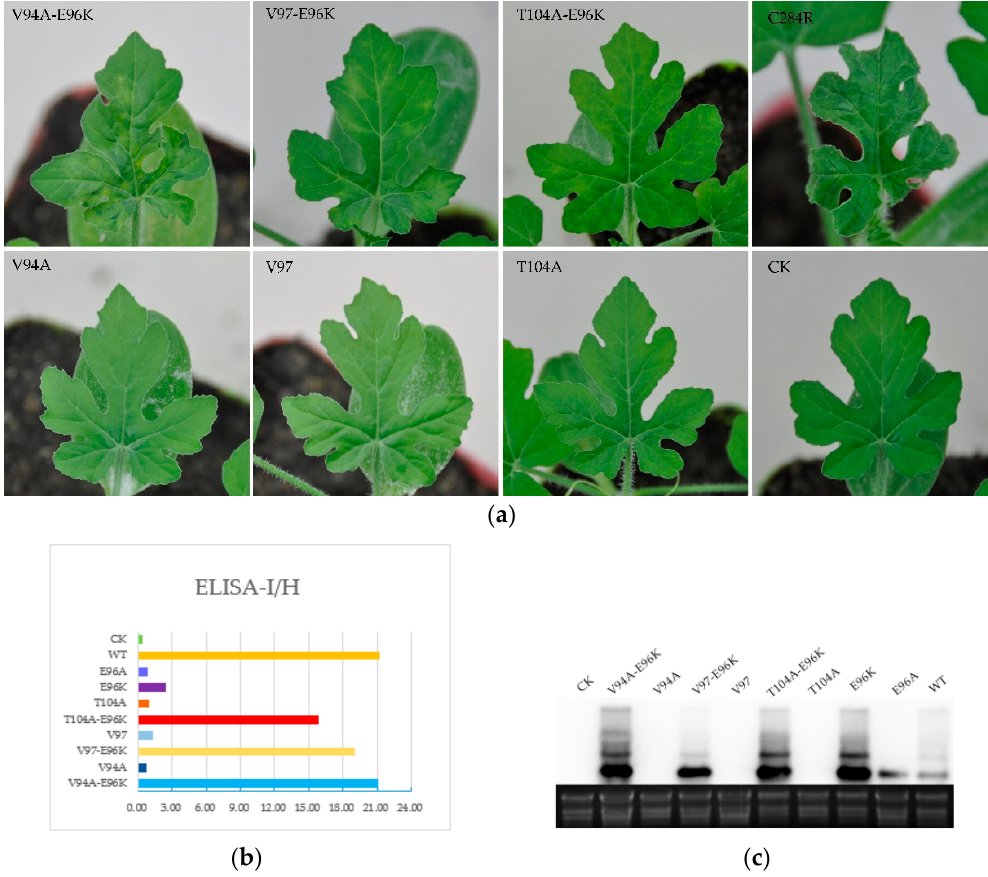
Figure 4. The relationship between the accumulation of mutant RNA and symptoms in watermelon. ( a ) Symptoms of watermelon inoculated with V94A, V97, T104A, V94A-E96K, V97-E96K, T104A-E96K, and C284R (WT) infected N. benthamiana leaves at 13 dpi; ( b ) CGMMV accumulation was determined using DAS-ELISA at 10 dpi. The abscissa displays the relative values of I/H: (sample-blank)/(negative control-blank). For all of the samples, an adjusted value of 3.0 or above was considered positive; ( c ) Northern blot analysis of V94A-E96K, V94A, V97-E96K, V97, T104A-E96K, T104A, E96K, E96A, and the WT at 17 dpi.